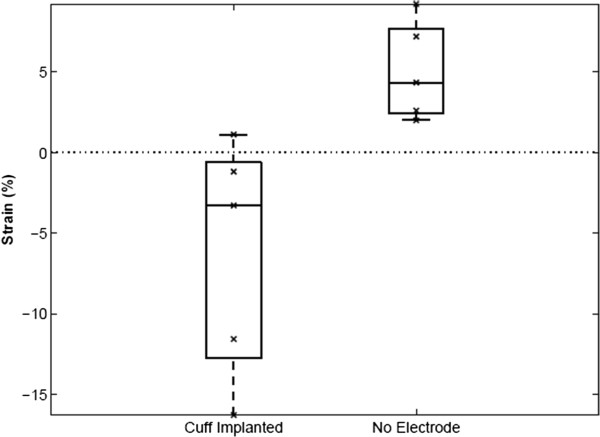
Average strain measurements for joint rotation with the cuff implanted (left) and without (right). Differences in the direction of stretch is obvious through the sign change. There is also a noticeable increase in range and standard deviation for the cuff versus control (no electrode).